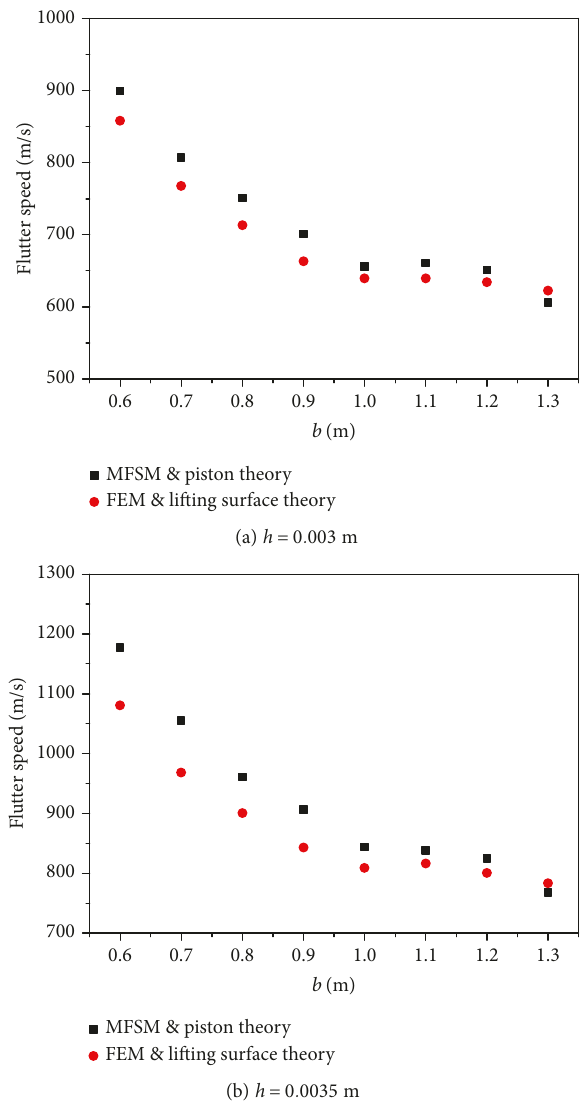
Figure 8: Flutter speeds of panels in di ff erent widths with di ff erent